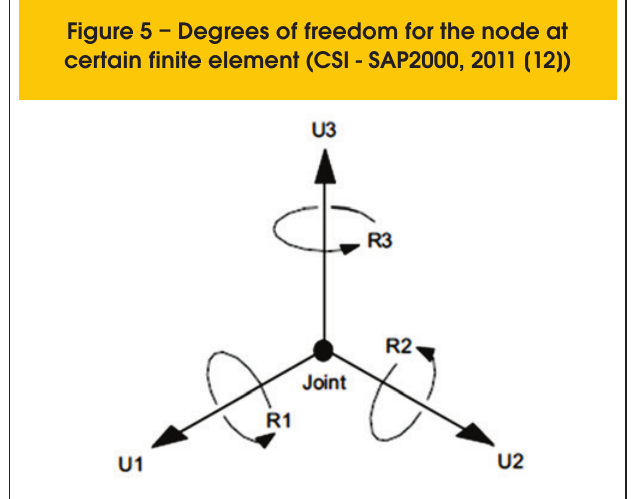
Figure 5 – Degrees of freedom for the node at certain finite element (CSI - SAP2000, 2011 [12])